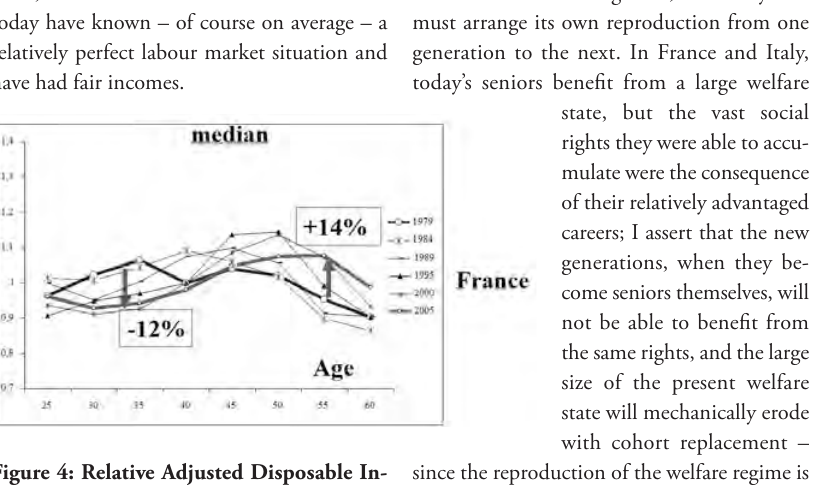
Figure 4: Relative Adjusted Disposable In- come (RADI) from 1979 to 2005 by Age Group 20 Th e main point is that France and Italy show profound redistributions of living standards to the benefit of seniors and at the expense of younger and mid-aged adults when Denmark and the United States face no massive trans- formations. When both the Nordic and Libe- ral welfare regimes are about to smoothen inter-cohort inequalities, the corporatist and the familialistic regimes generate visible imba- lances between age